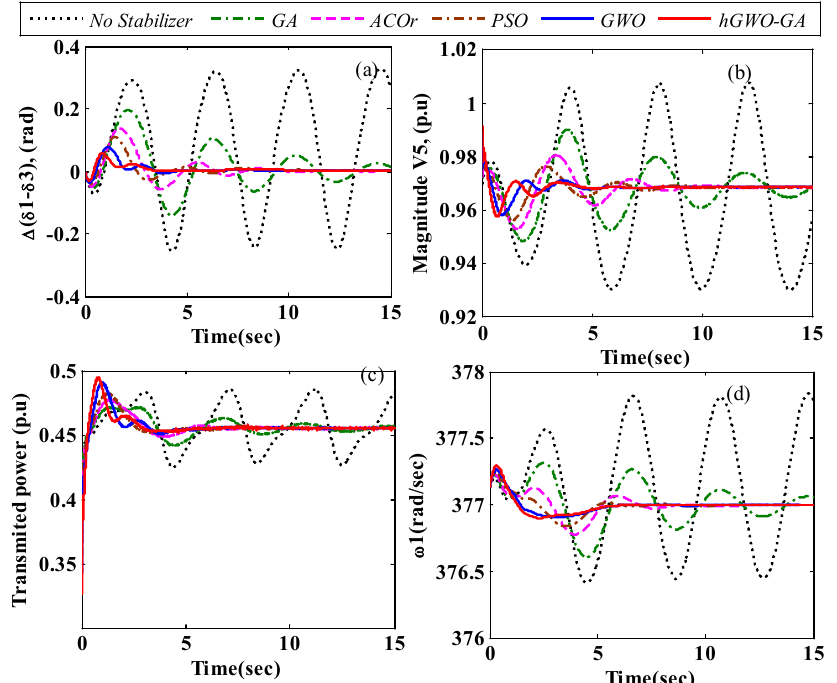
Figure 17. Nonlinear simulations in heavy loading using a robust m -based stabilizer for different optimization algorithms (( a ) angle difference between G 1 and G 3 , ( b ) magnitude of voltage bus 5, ( c ) transmitted power between area1 and area2, ( d ) rotor speed of generator G1).